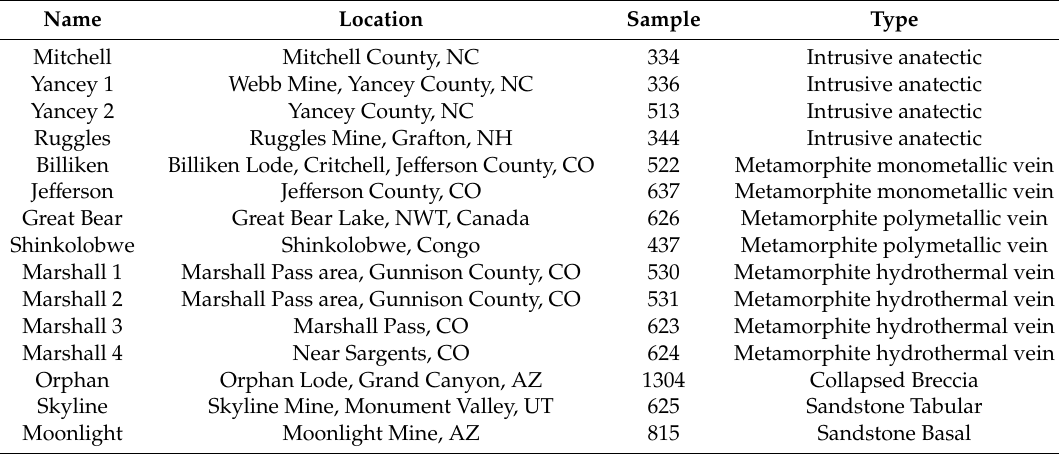
Table 1. A list of uraninite samples, reported here, with their accompanying deposit type and source location. Uraninite sample number corresponds to the Ewing Collection sample